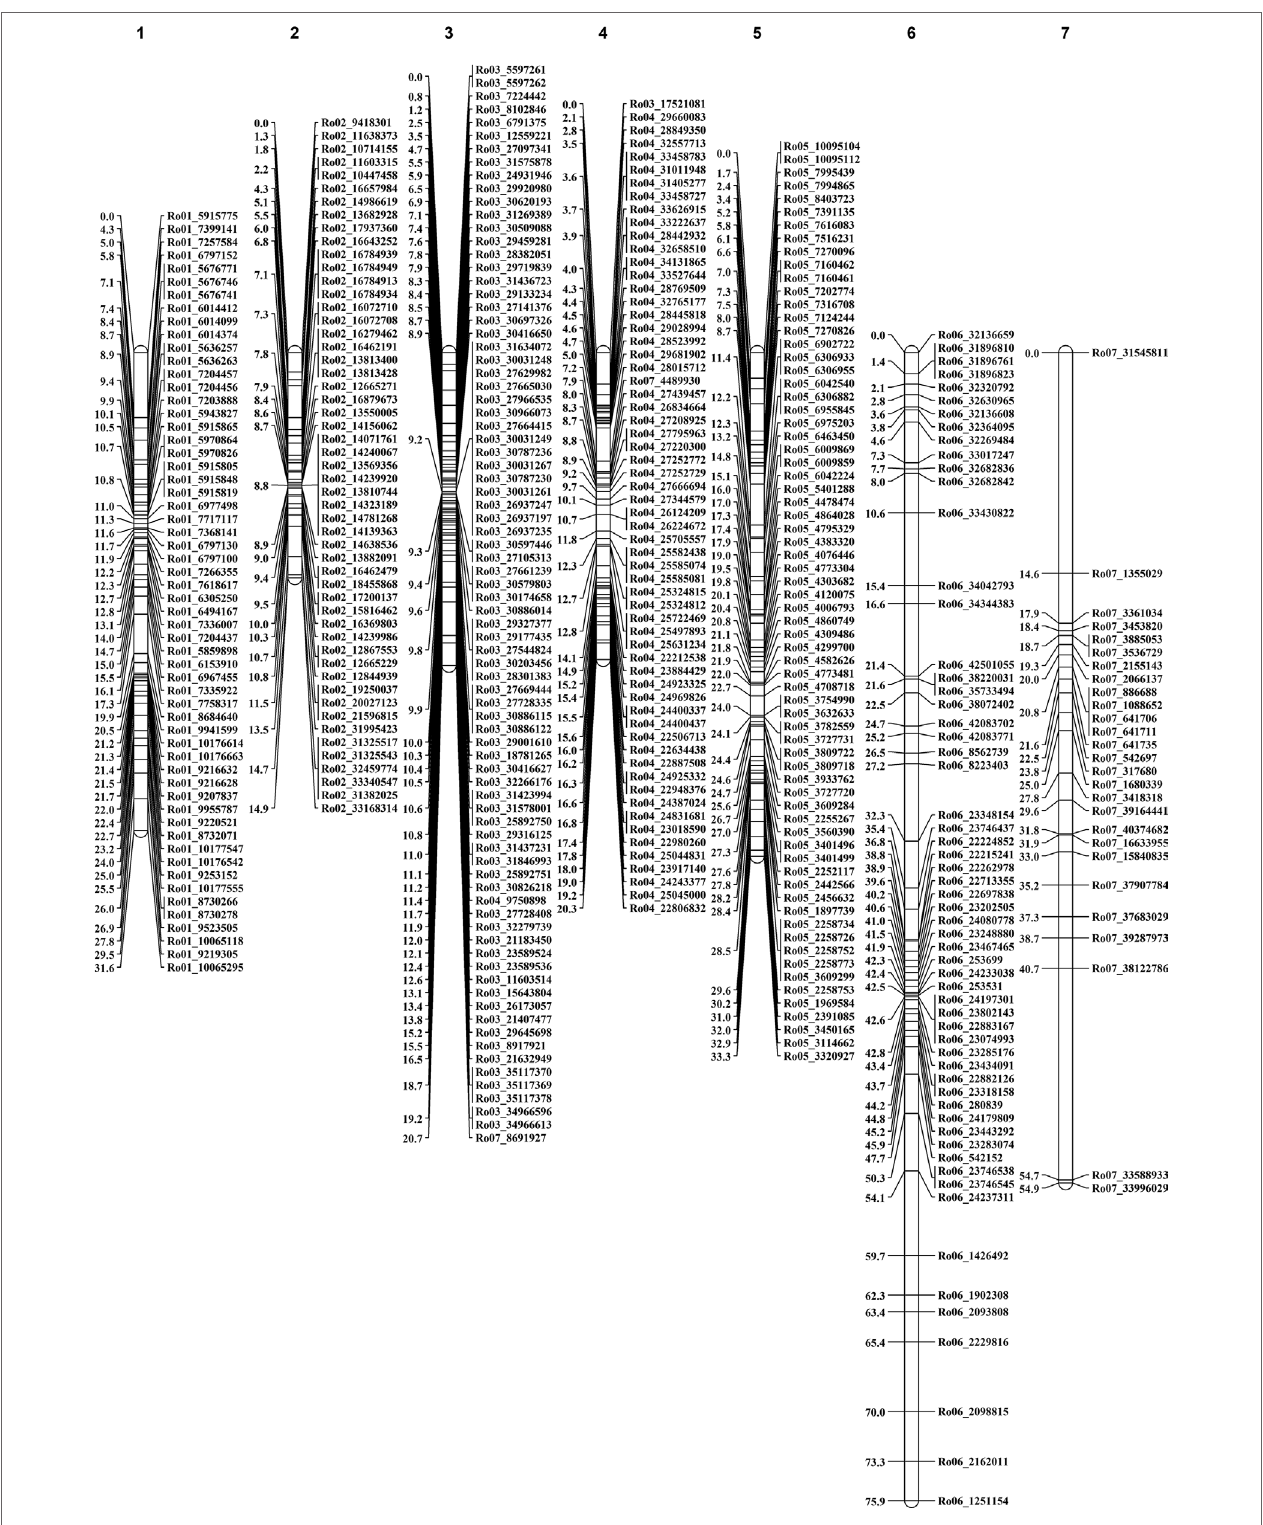
FIGURE 2 | Rubus idaeus linkage map for Biennial-Fruiting (BF) parent ‘Chilliwack’. Each linkage group (represented by a vertical bar) was constructed using SNP loci generated by genotyping by sequencing (GBS). The lines across the bars represent marker positions in the map, and the scale on the right represents the genetic distance in centiMorgan (cM). All markers segregated according to the Mendelian ratio at p < 0.005, and markers were named according to their physical positions in the genome (right-hand side of each LG). The maps were generated in Joinmap v5.0 ® (Van Ooijen and Voorrips,